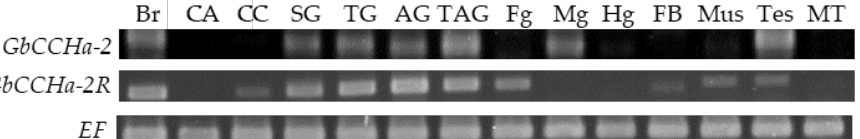
Figure 1. RT-PCR analyses of the tissue distributions of GbCCHa-2 and - 2R in male eighth-instar nymphs. Elongation factor ( EF ) was used as the internal control gene. No-RT negative control and no-template control yielded no amplification products (Supplementary Materials, Figure S1). Br,